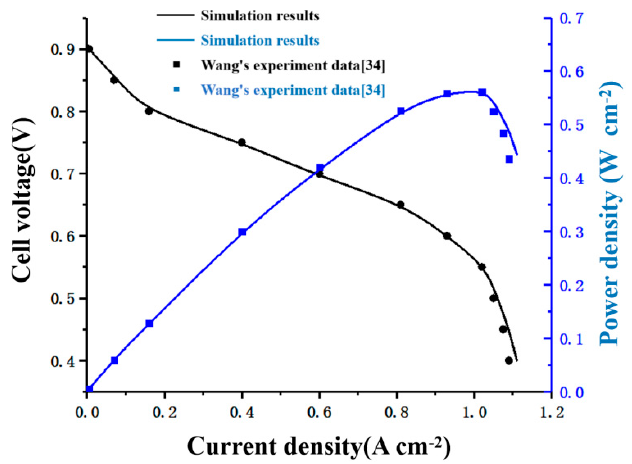
Figure 4. Comparison between the predicted and measured I − V curves and I ‐ P curves of a PEMFC with parallel flow field.